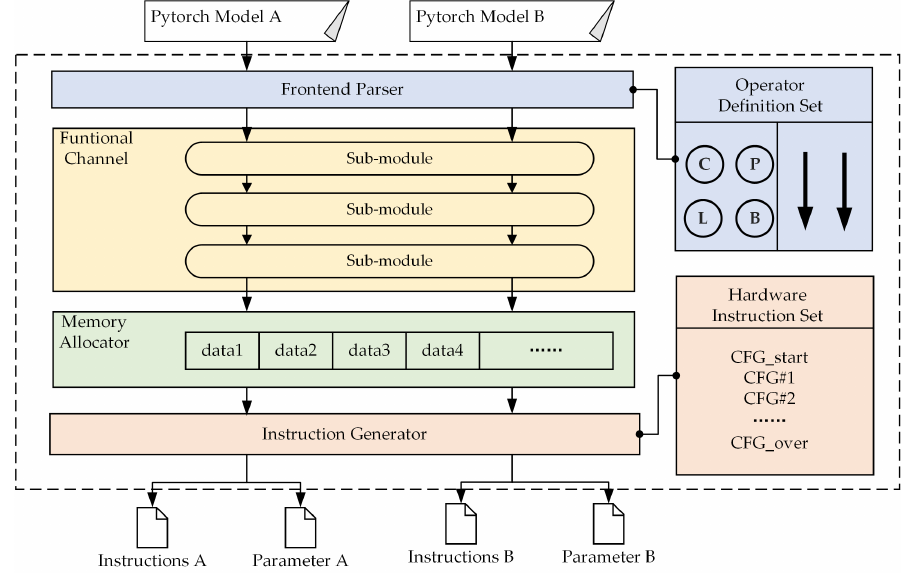
Figure 12. The overview of the compilation toolchain